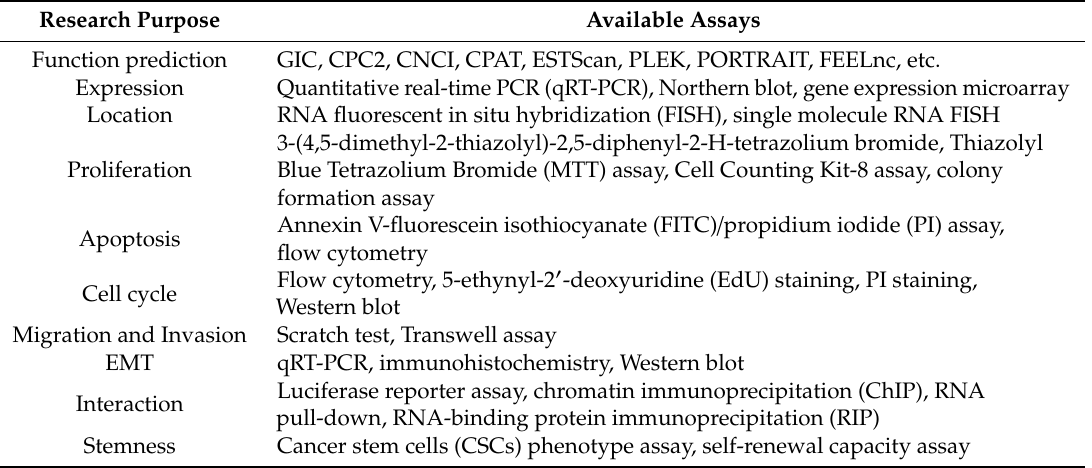
Table 1. Methodologies for exploring the expression, distribution, and function of